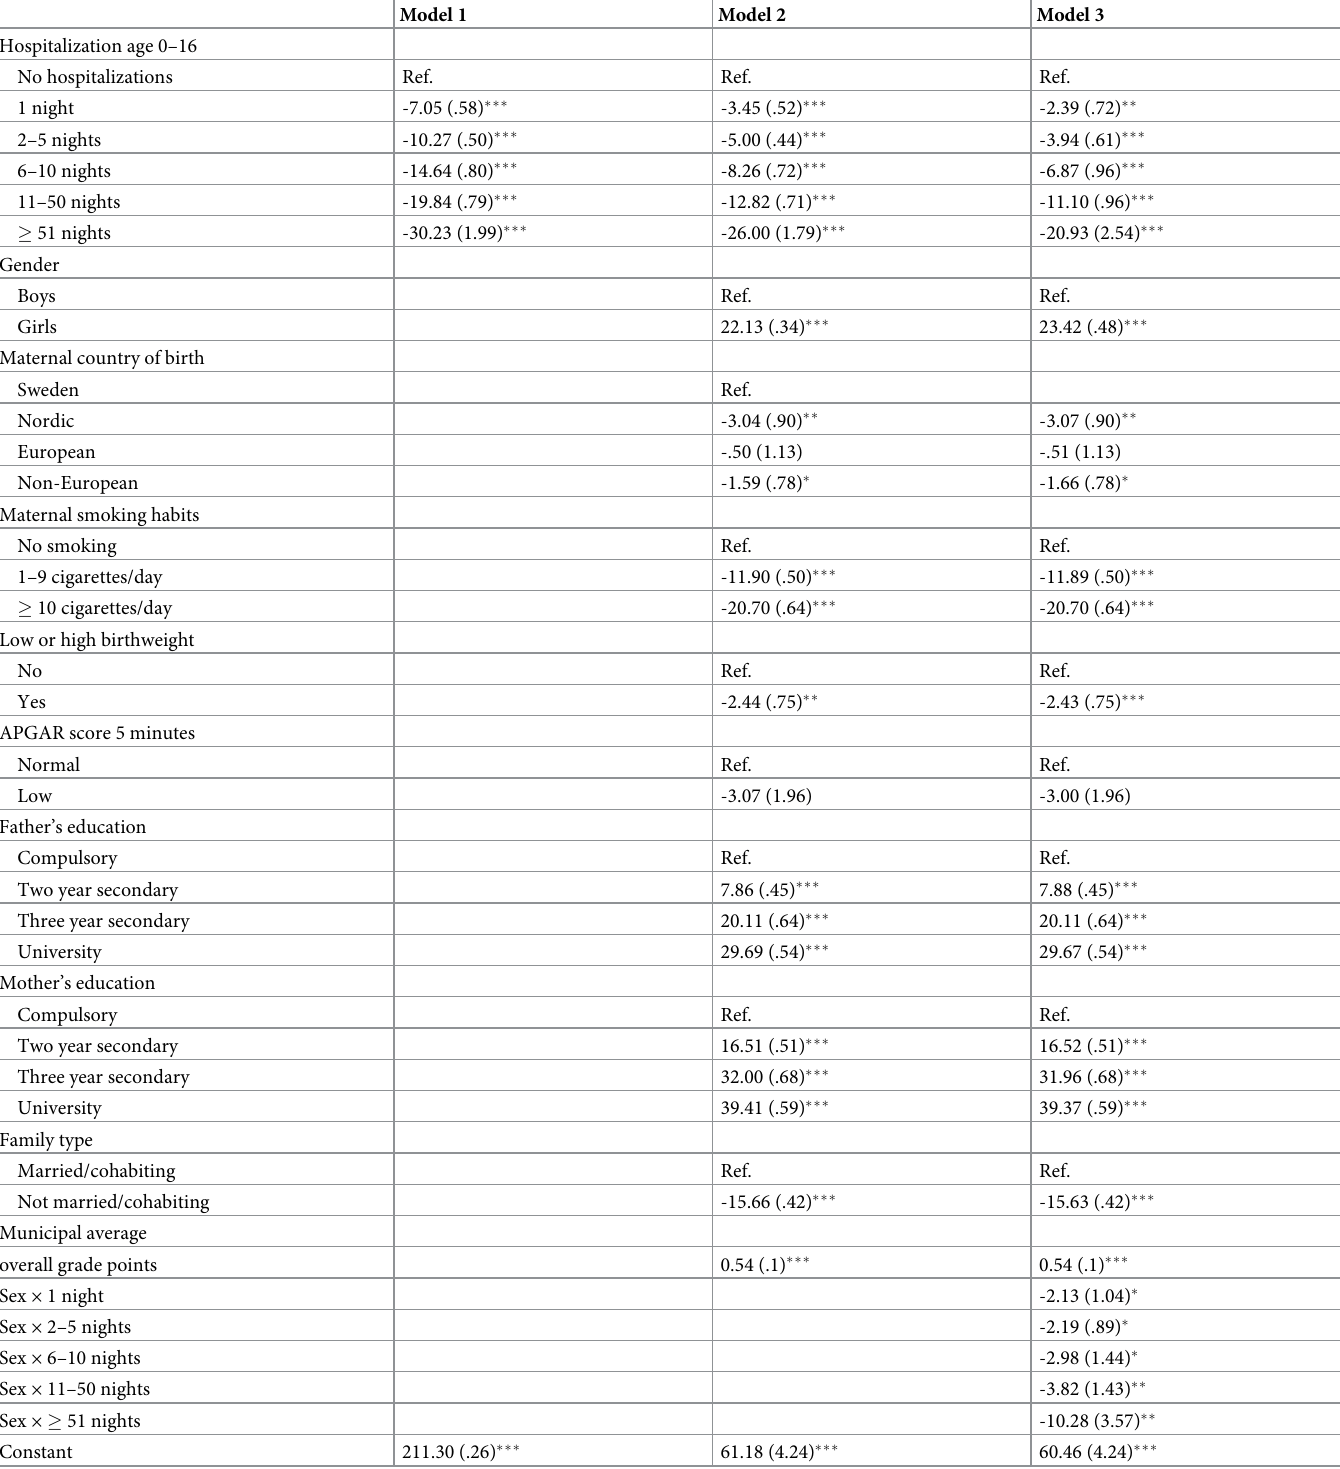
Table 2. Linear regression models showing associations between hospitalizations and overall grade points , unstandardized beta-coefficients, standard error in